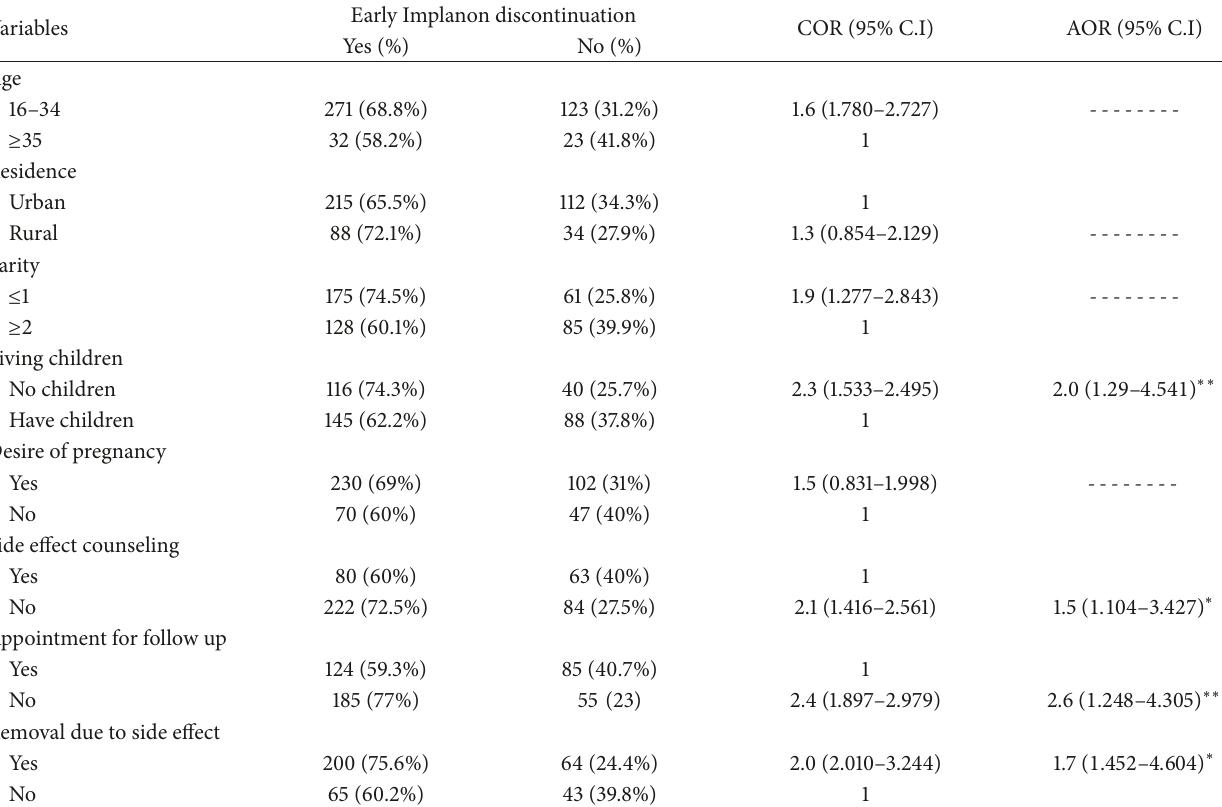
Table 4: Factors associated with early Implanon discontinuation among Implanon user women in Debre Tabor town public health facilities, northwest Ethiopia,